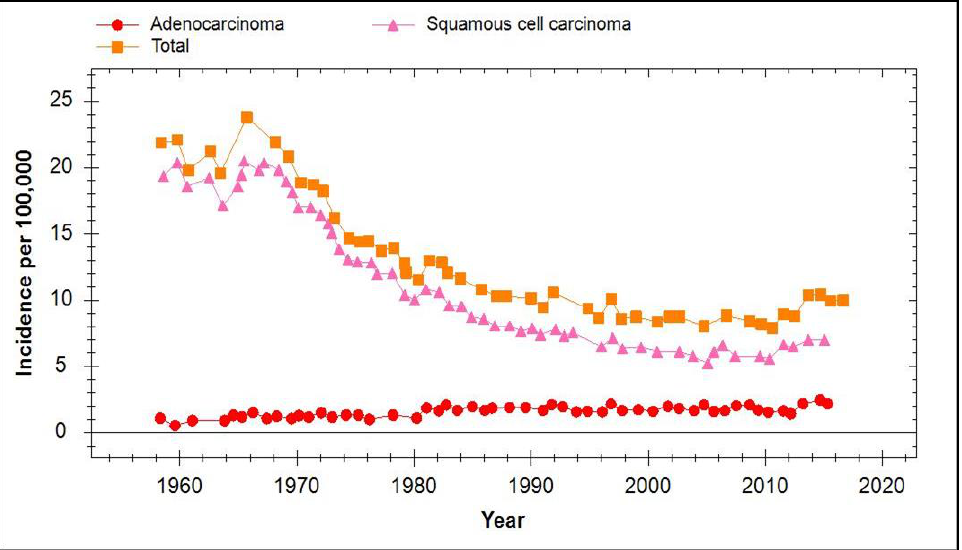
Figure 8. Incidence of cervical cancer in Sweden from 1960 to 2017.